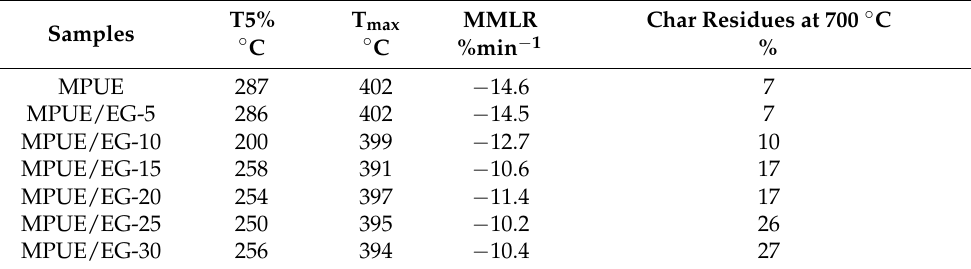
Table 8. Cone calorimeter analysis of MPUE/EG.